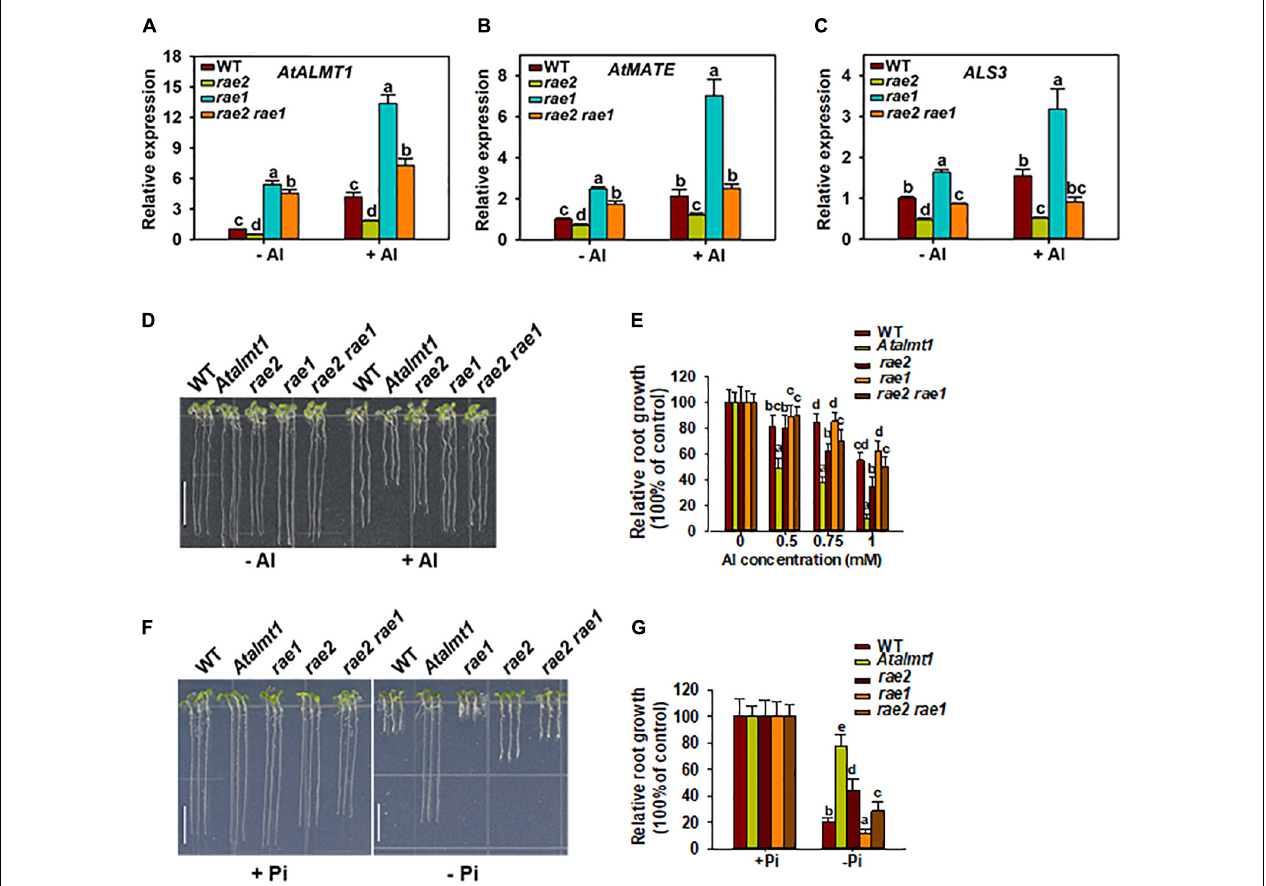
FIGURE 7 | Introduction of rae1 mutation partially restores the defective phenotypes of rae2. (A–C) Expression analysis of STOP1-regulated genes, including AtALMT1 (A) , AtMATE (B) and ALS3 (C) , in WT, rae2 , rae1 , and rae2 rae1 . Seedlings with 7 days old were exposed to 0 (–Al) or 30 µ M Al (+Al) for 12 h, and then roots were excised for the expression analysis. Values are means ± SD ( n = 3). (D,E) Representative images (D) and Al resistance (E) of WT, Atalmt1 , rae2 , rae1 , and rae2 rae1 under different Al concentrations. Values are means ± SD ( n = 13–18). (F,G) Representative images (F) and relative root growth (G) of WT, Atalmt1 , rae2 , rae1 , and rae2 rae1 at 20 (–Pi) or 1,000 Pi (+Pi). Scale bar = 7 mm. Values are means ± SD ( n = 39–56). Means with different letters are significantly different ( P < 0.05, ANOVA followed by Tukey’s